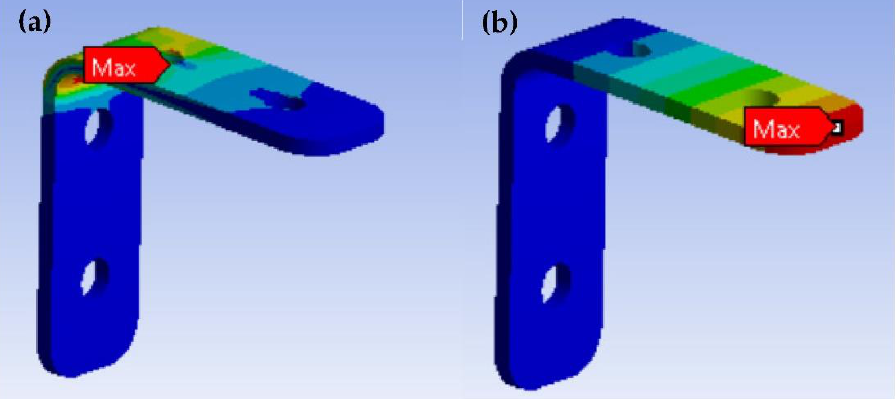
Figure 4. Simulation results of Mode-1 showing ( a ) maximum stress and ( b ) maximum